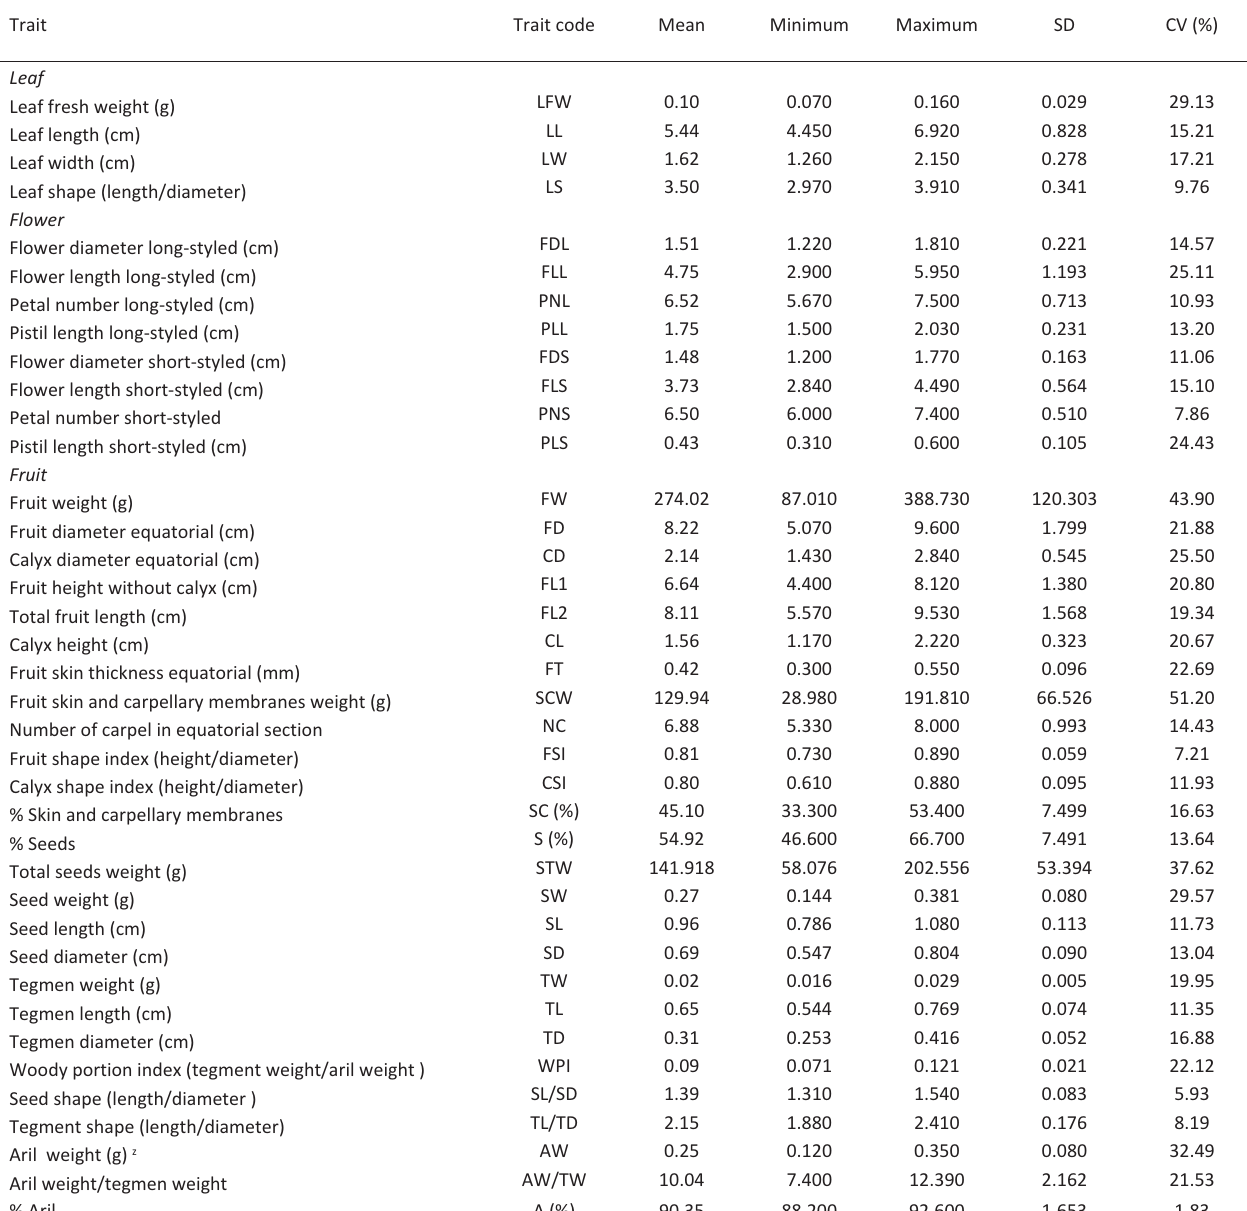
Table 2 ­ Quantitative traits used for characterizing pomegranate accessions and their descriptive statistics analysis using the mean, minimum, maximum, standard deviation (SD) and coefficient of variation